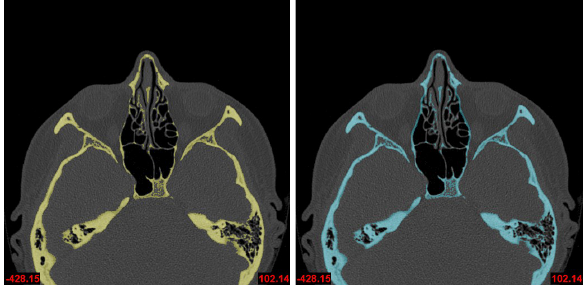
Figure 5. Example of editing tomograms for the restoration of thin bone and cartilage walls and computer models obtained as a